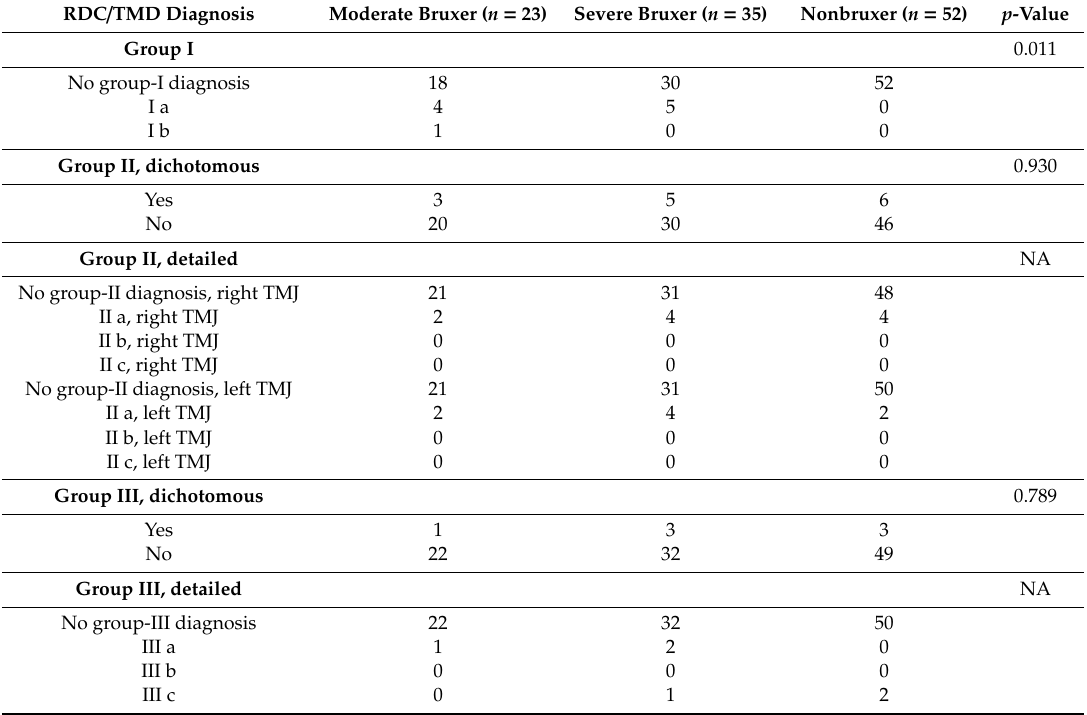
Table 1. Correlation between moderate ( > 2 and ≤ 4 SB episodes / h) and severe ( > 4 SB episodes / h) sleep bruxism and a diagnosis in accordance with the RDC / TMD. RDC / TMD Diagnosis Moderate Bruxer ( n = 23) Severe Bruxer ( n = 35) Nonbruxer ( n = 52) p -Value Group I 0.011 No group-I diagnosis 18